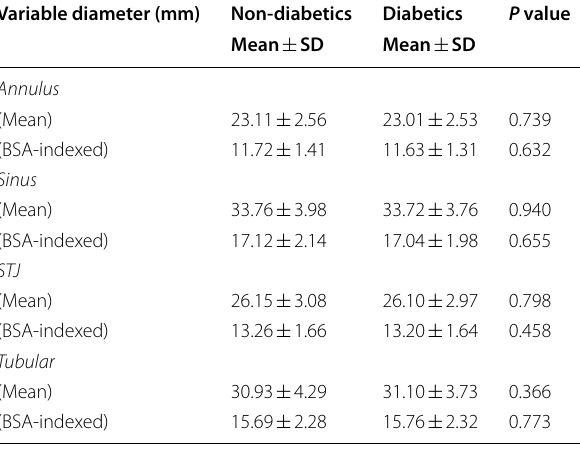
Table 19 Comparison of ascending thoracic aorta diameters in diabetic and non‑diabetic